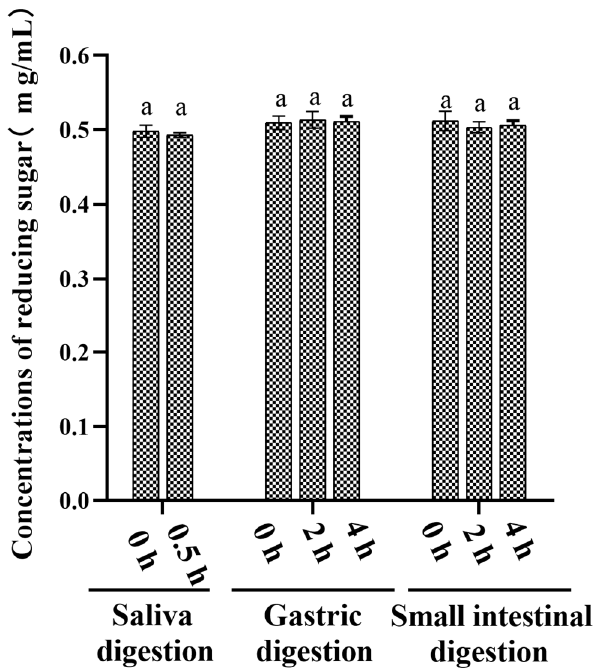
Figure 3. Changes in reducing sugars of AABP-2B during simulation of upper gastrointestinal di- gestion. Statistically signi fi cant di ff erences were observed between di ff erent le tt ers ( p < 0.05).